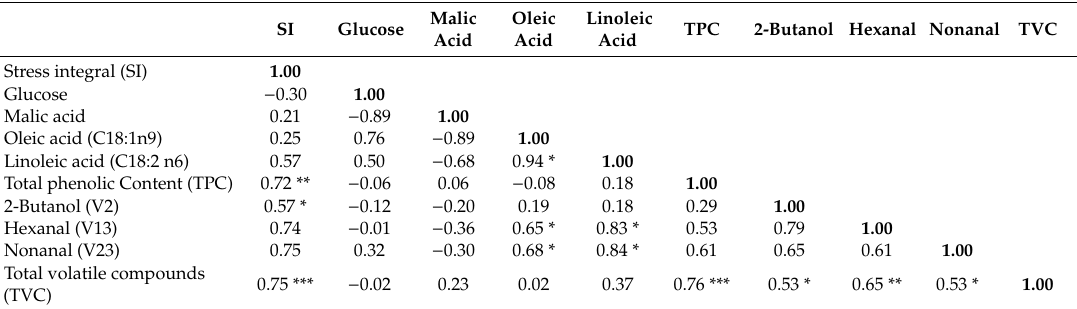
Table 5. Pearson’s correlation coe ffi cients ( R ) among